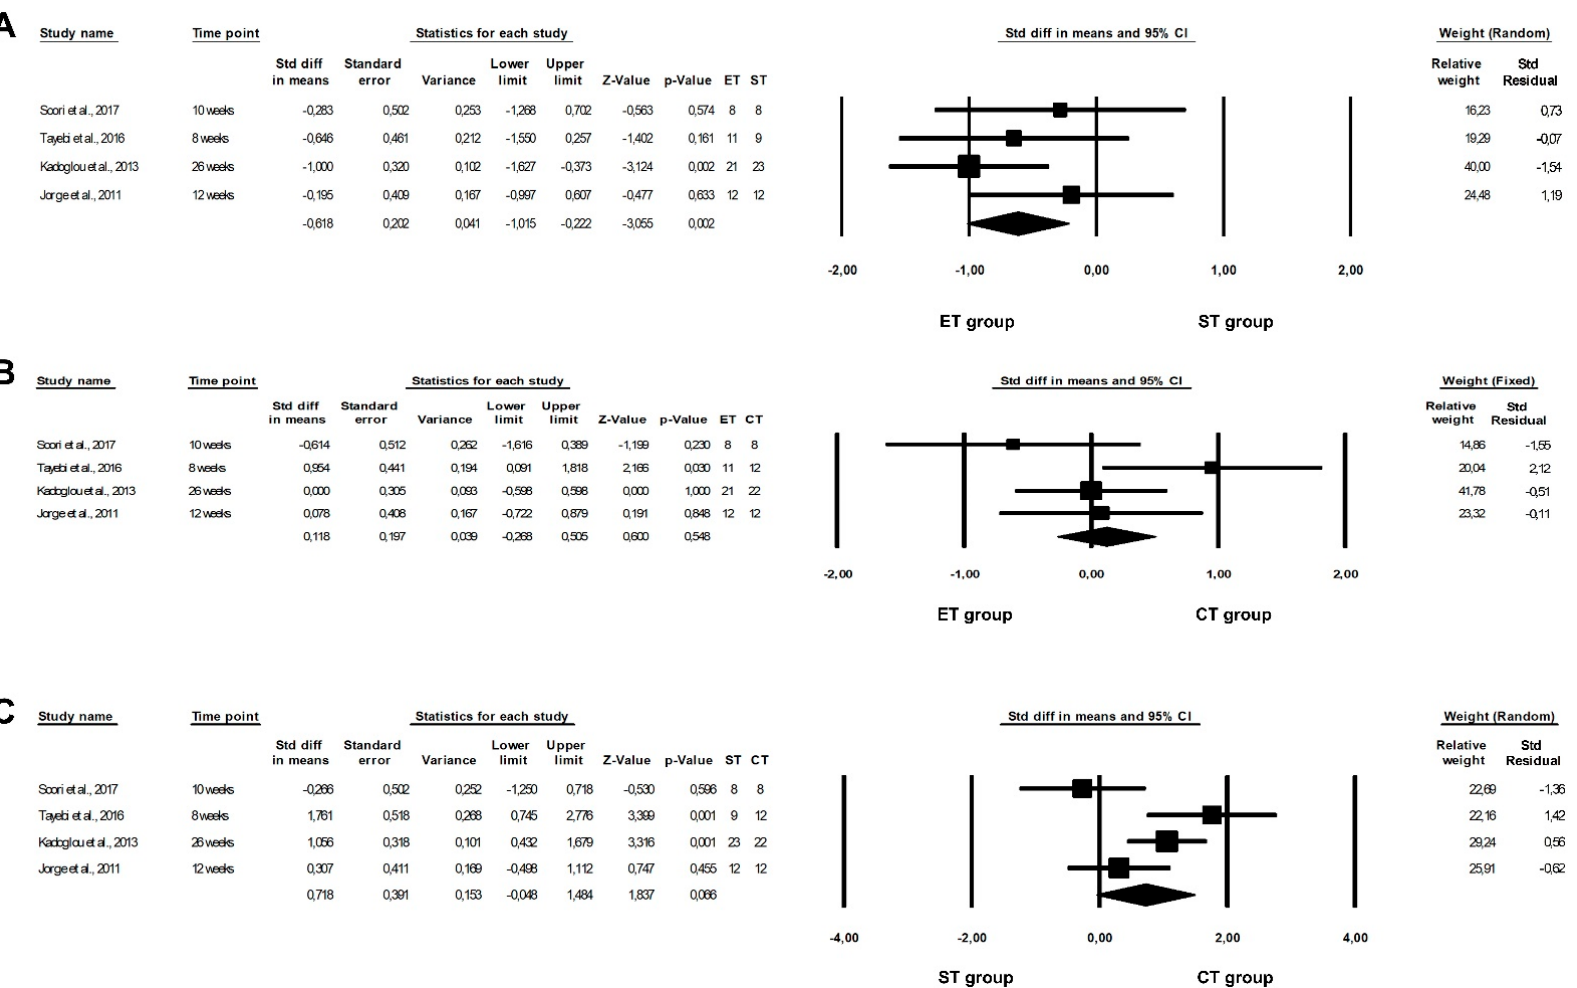
Figure 7. Forest plots of the effect of different training programmes on visfatin levels: ( A ) ET vs. ST—random model; ( B ) ET vs. CT—fixed model; ( C ) ST vs. CT—random model. CI—confidence interval; CT—combined training; ET—endurance training; ST—strength training; Std diff—standard differences [15,18,25,37].